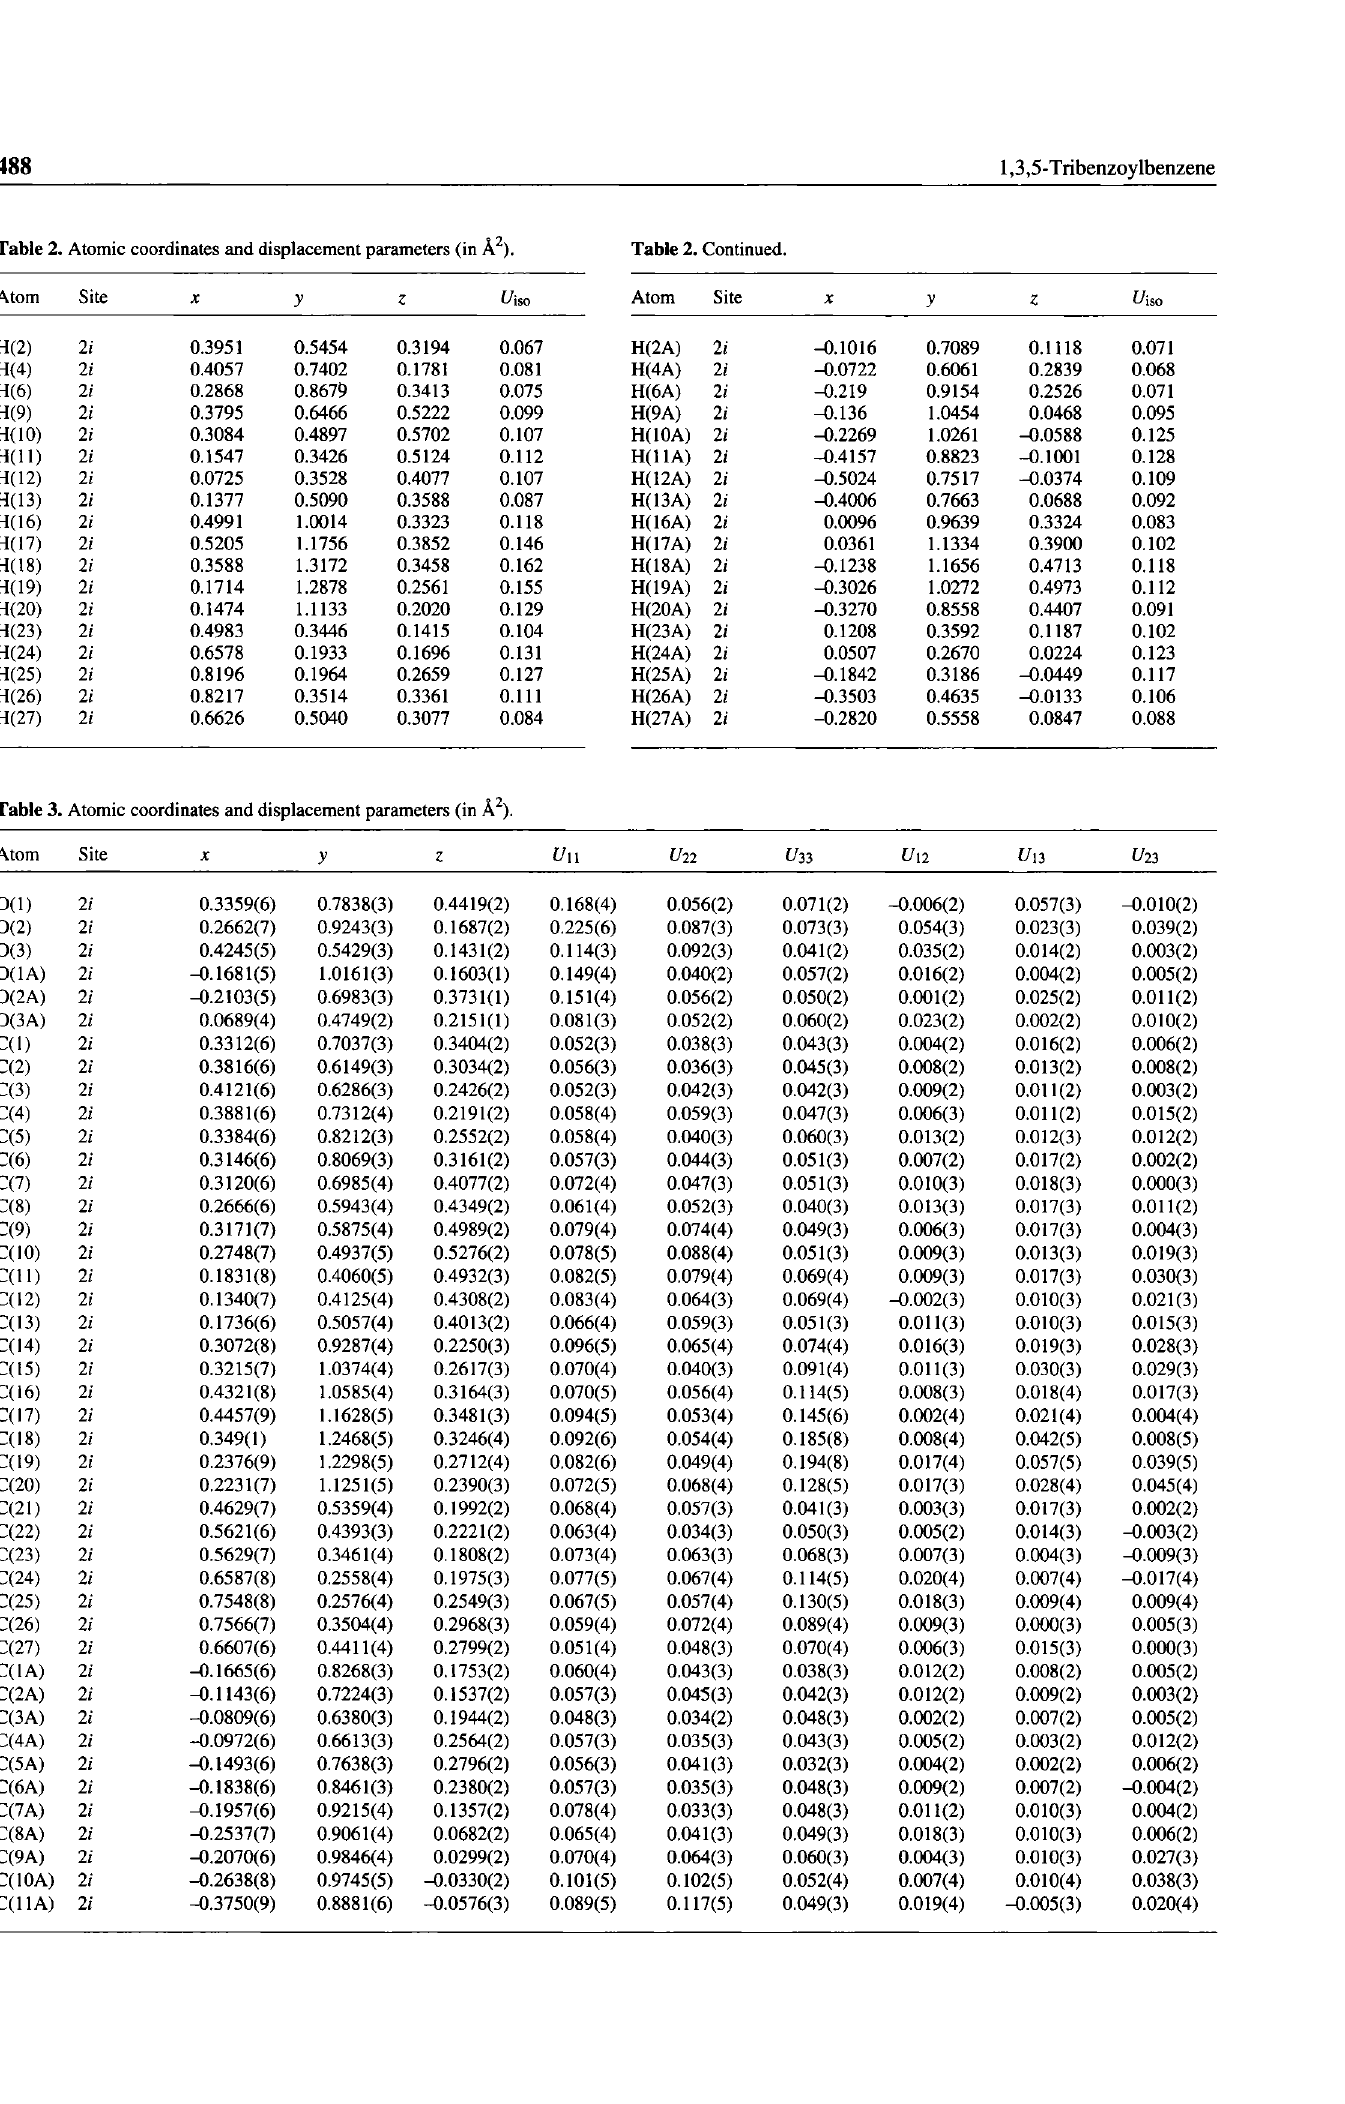
Table 3. Atomic coordinates and displacement parameters (in Ä 2